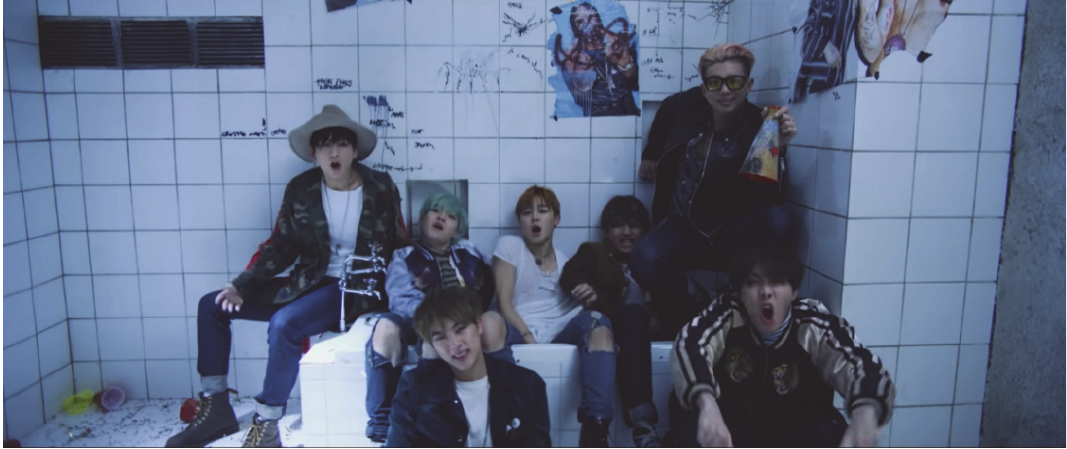
<Figure 2> Image of Friendship in BTS. (2015b). “Run” Official